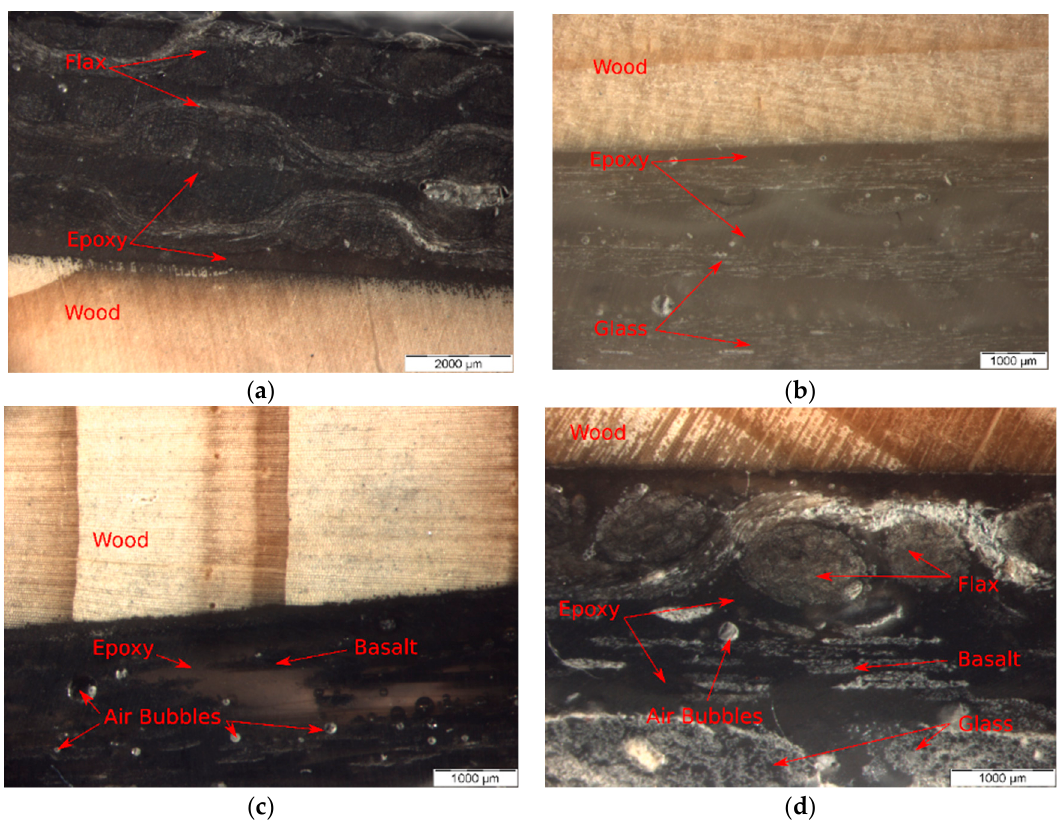
Figure 6. Light microstructure of ( a ) flax (F)FRP–wood, ( b ) E-glass (G)FRP–wood, ( c ) basalt (B)FRP– wood and ( d ) hybrid FRP–wood.